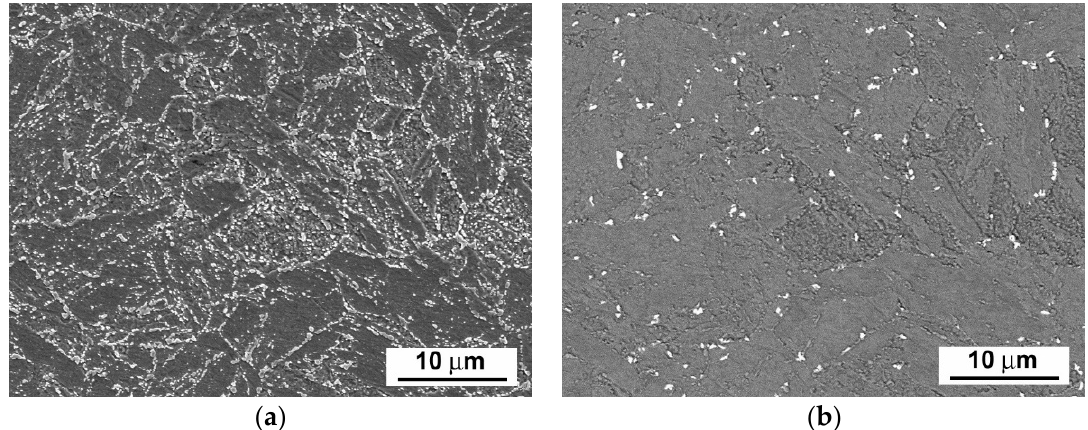
Figure 4. SEM images of investigated P92 steel in thermally aged material condition (600 °C/2.5 kh) visualized by ( a ) secondary electrons and ( b ) back-scattered electrons.